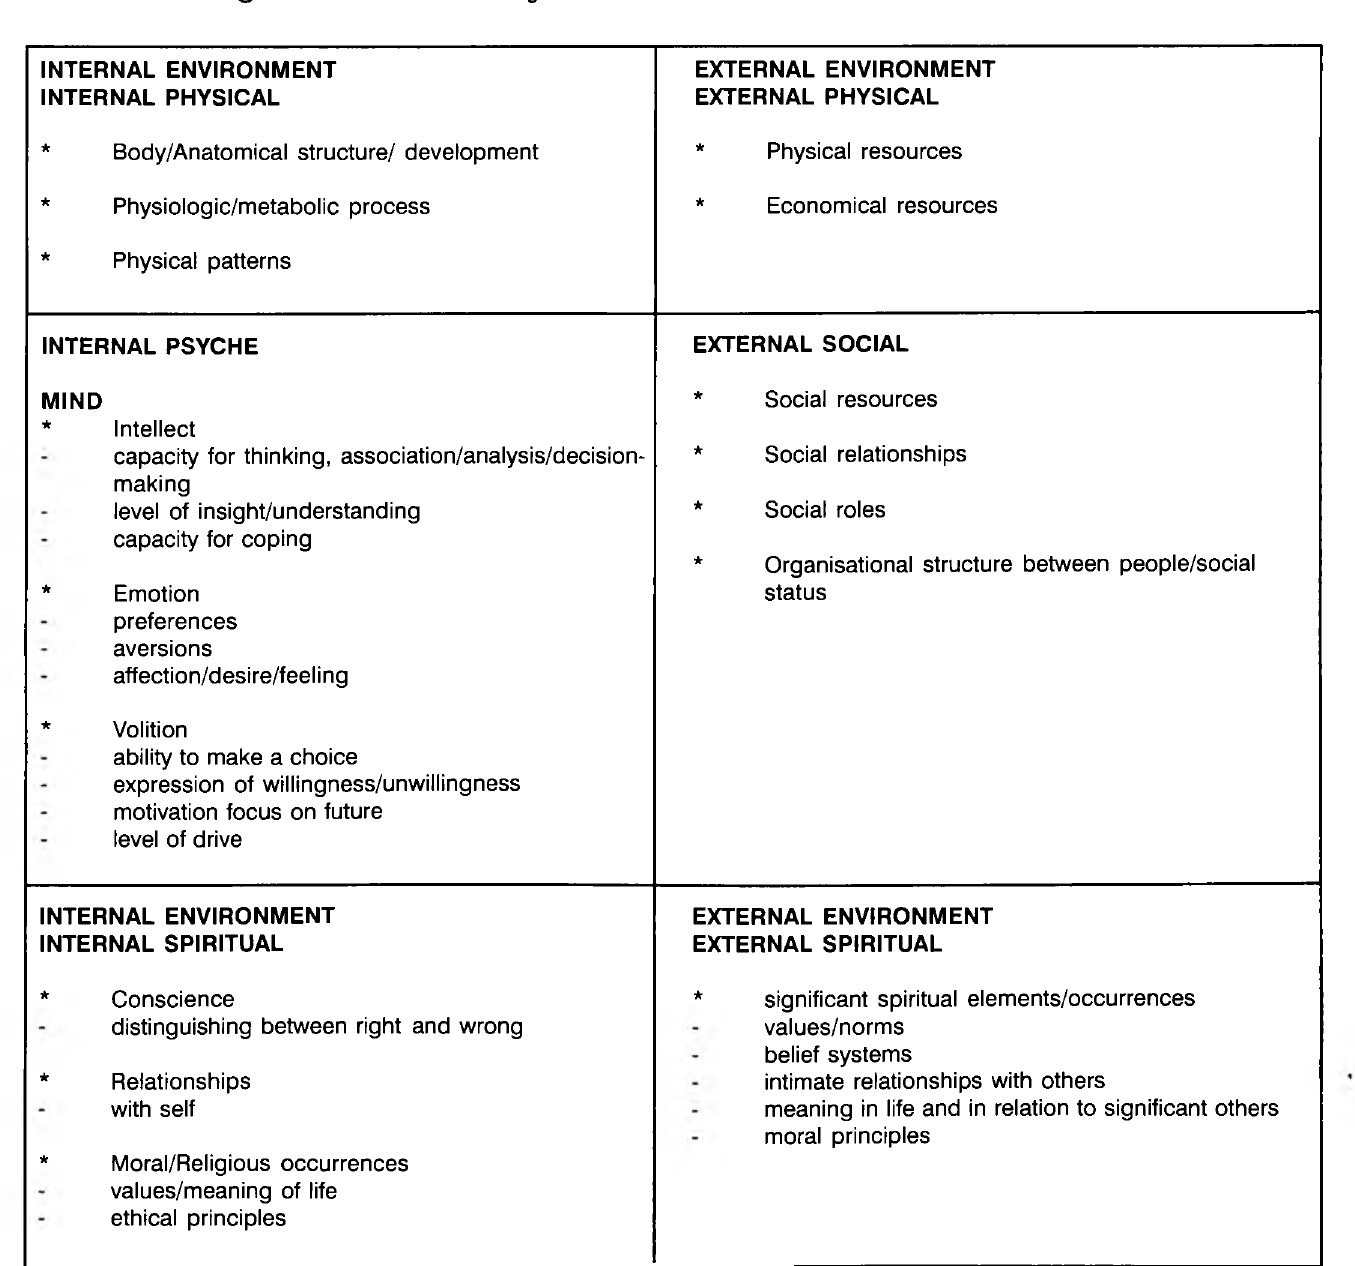
Table 1 : Categories for data